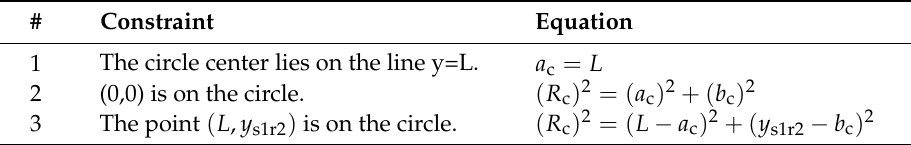
Figure 13. Constructing the interpolation for Section 1. Table 4. Circle constraints.